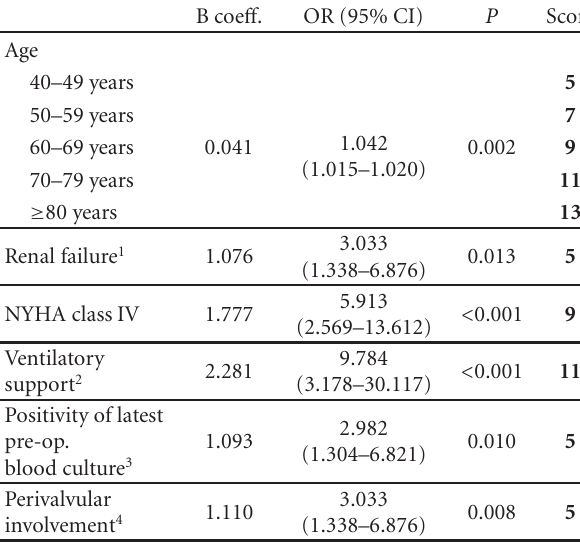
Table 2: Independent preoperative predictors of mortality (logistic regression analysis) and the deriving scoring system for mortality prediction in native valve IE.